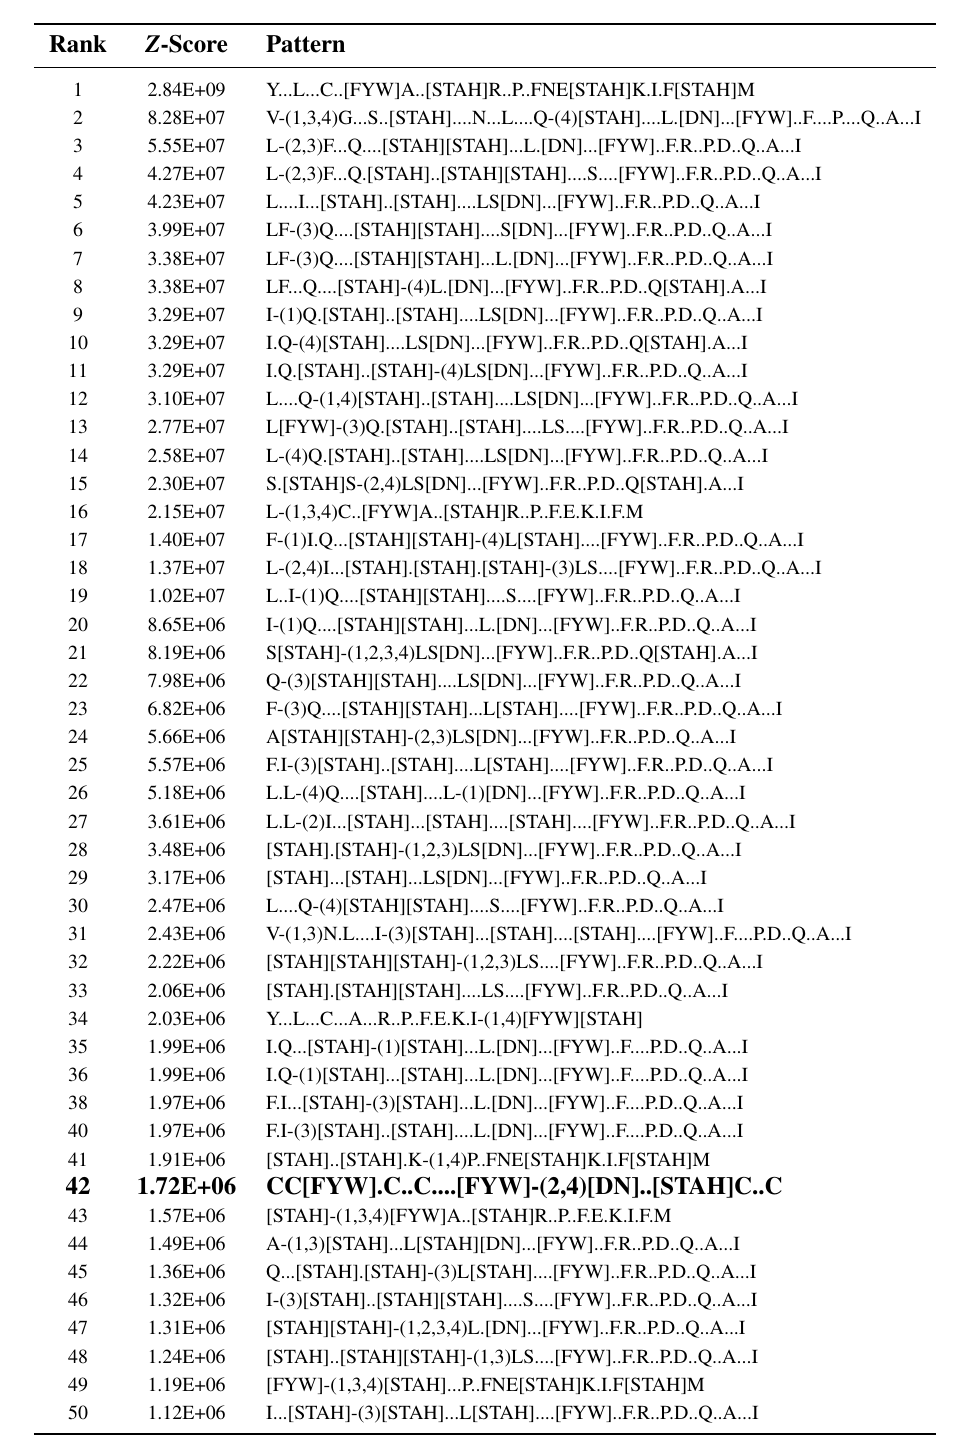
Table 1. Output of Varun for the G-protein coupled receptors family 3 (id PS00980), consisting of 25 sequences of about 25,000 amino acids each. One of the relevant signatures is shown in bold